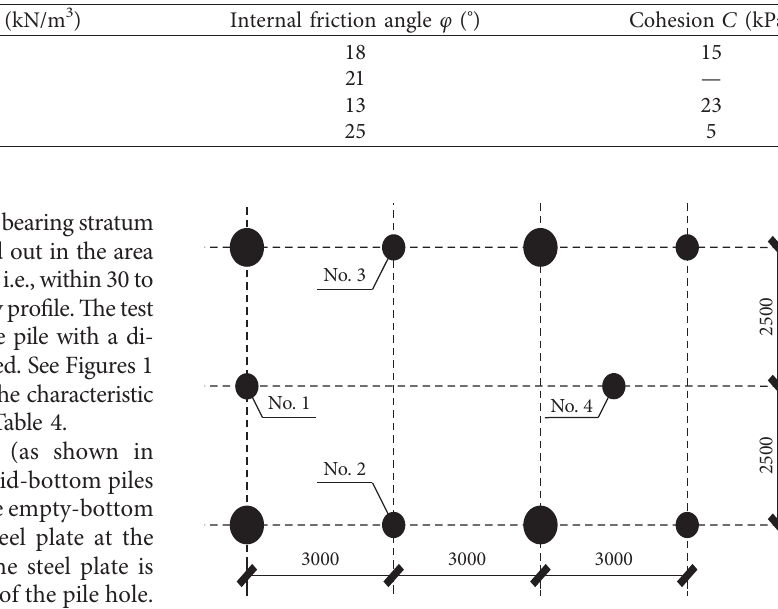
Figure 4: Layout of pile